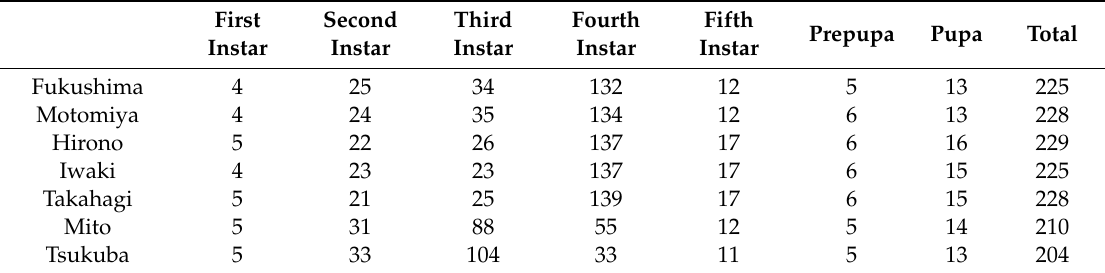
Table 4. Number of days required for each instar and stage in